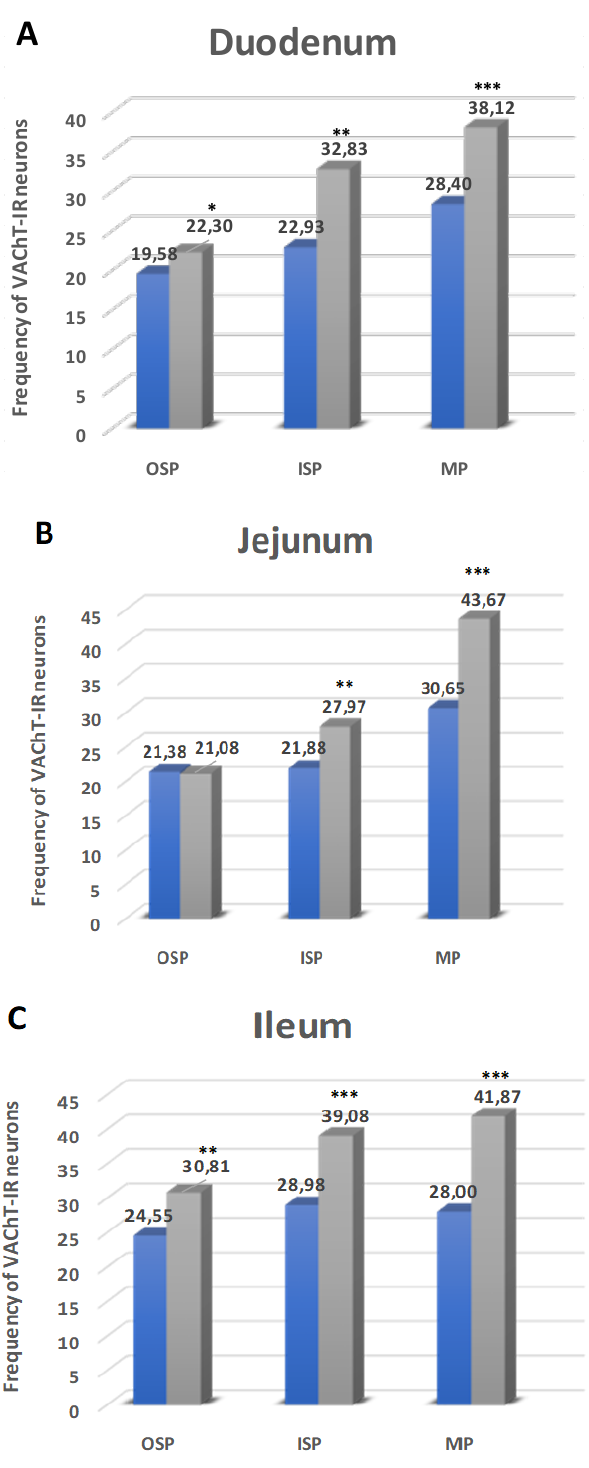
Figure 9. Schematic diagram of the numbers of perikarya immunoreactive to vesicular acetylcholine transporter (VAChT) ( A–C ) of the control (blue bars) and experimental group (grey bars) in the particular parts of the small intestine. OSP – outer submucosal plexus, ISP – inner submucosal plexus, MP – myenteric plexus. * p < 0.05, ** p < 0.01, *** p < 0.001 – indicate differences between all groups for the same neuronal populations.